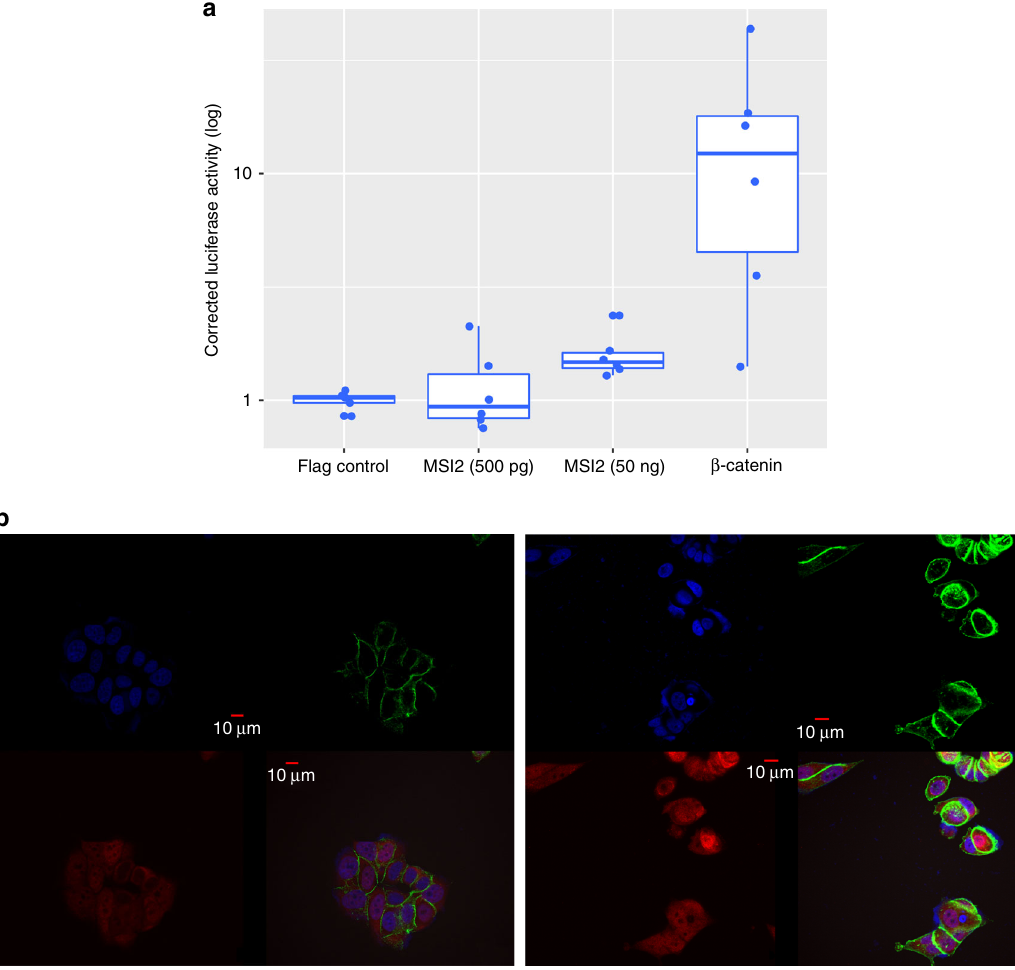
Fig. 3 MSI2 overexpression activates the Wnt cascade. a MSI2 overexpression results in a signi fi cant 1.5-fold linear increase in TOPFLASH Luciferase activity, relative to Flag control (paired Student ’ s t test; p < 0.05; please note the log scale). b MSI2 overexpression mediates β -catenin localisation to the nucleus, with no change in the total intracellular β -catenin levels. Left panel: representative immuno fl uorescence image of control MCF7 (nucleus is highlighted with blue DAPI staining; β -catenin is stained green; and MSI2 is red). β -catenin is largely localised to the membrane and the cytosol. Right panel: representative immuno fl uorescence image of MCF7 MSI2 overexpression clones, with β -catenin localisation to the abundance was signi fi cantly negatively associated with ER and